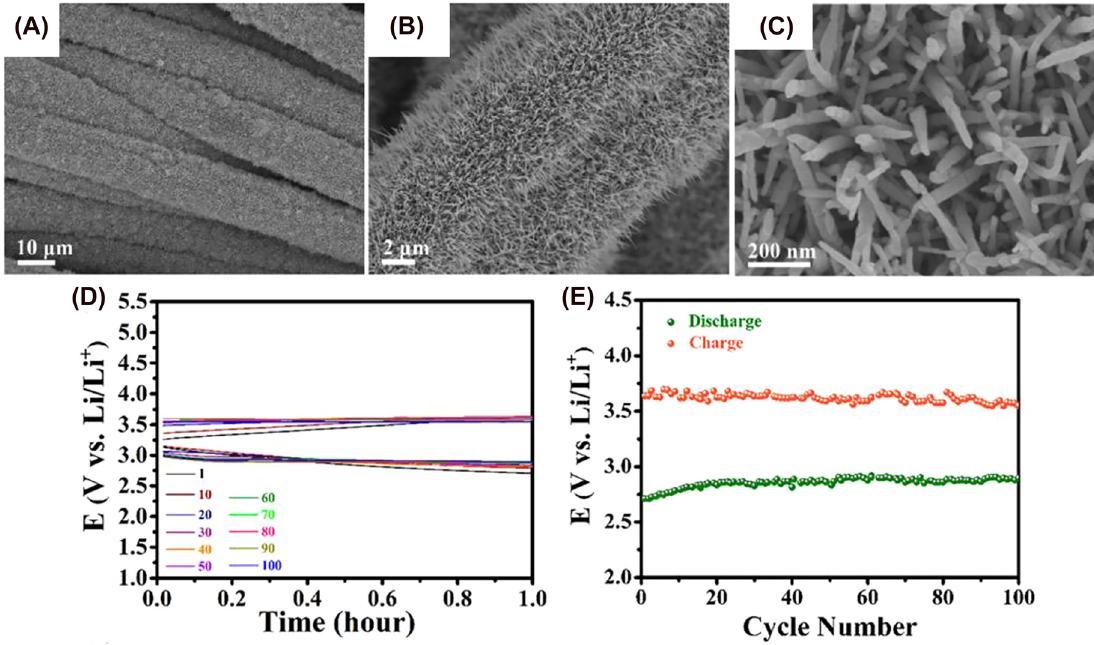
Figure 6: Structure and performance of tungsten trioxide-based